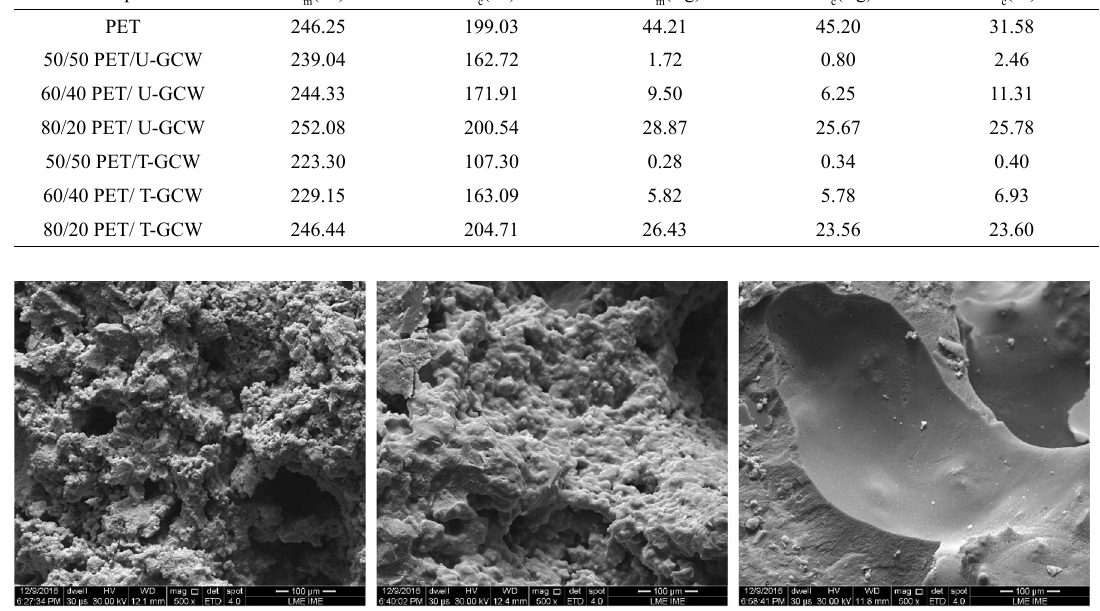
Figure 11. SEM electron micrographs of fracture of the PET/U-GCW composites: (a) 50/50 (b) 60/40 and (c) 80/20.